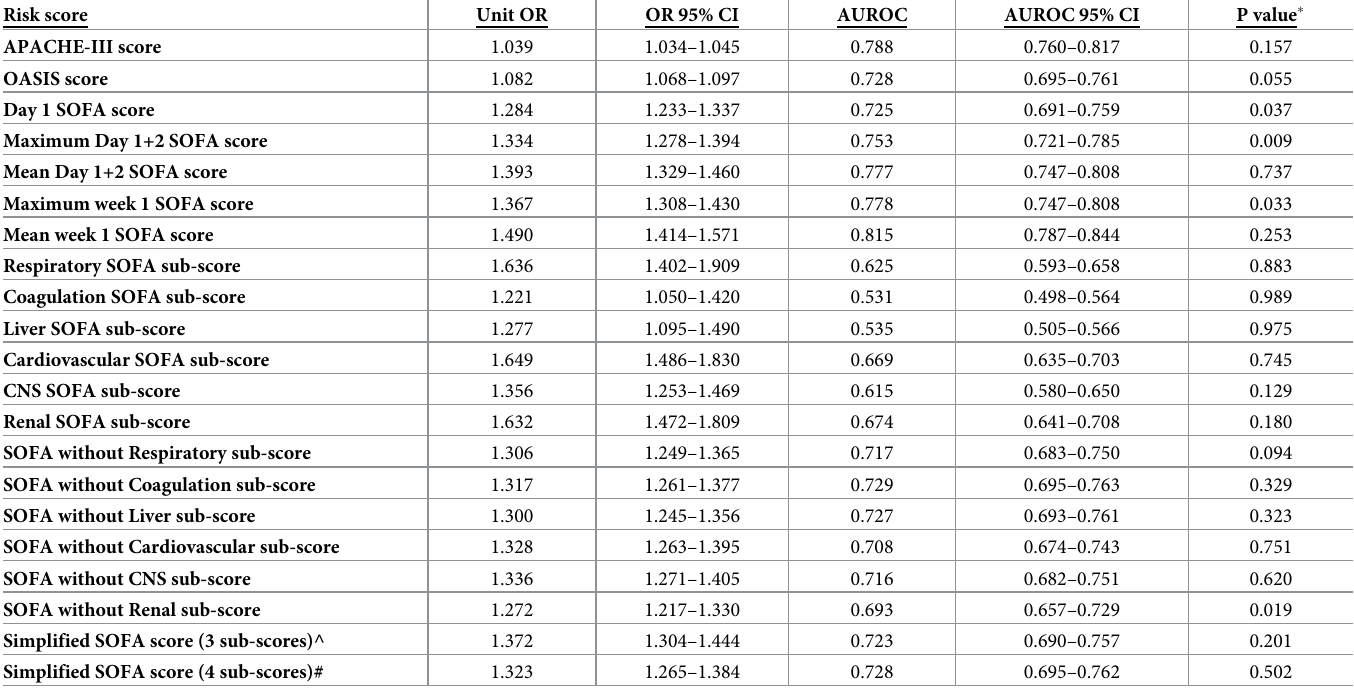
Table 2. Univariate analysis of illness severity scores as predictors of hospital mortality in the final study population (n =